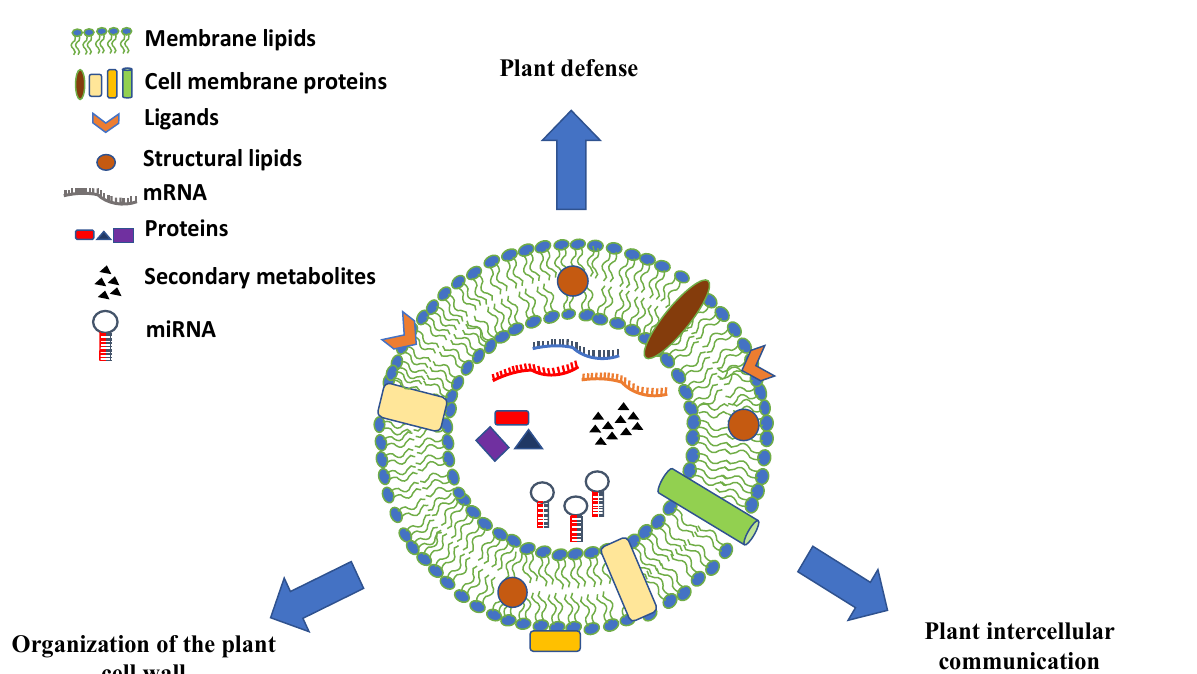
Figure 3. Schematic representation, composition, and biological roles of plant-derived vesicles. Plant vesicles are round- shaped nano and microstructures containing a vast array of proteins, nucleic acids (mRNAs, miRNAs, and other types of short RNAs), and secondary metabolites surrounded by a lipid bilayer with membrane proteins, channels, ligands, and receptors.